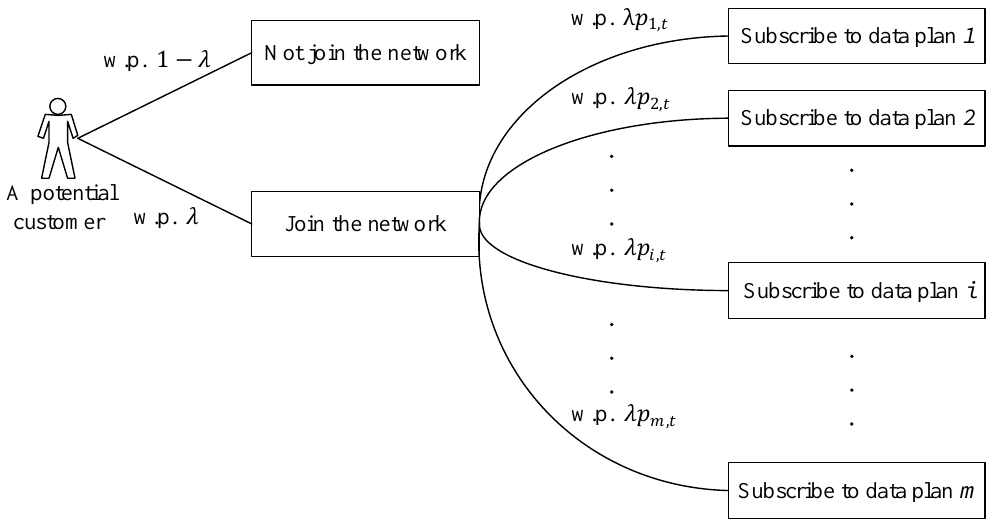
Figure 3. Decisions of the potential